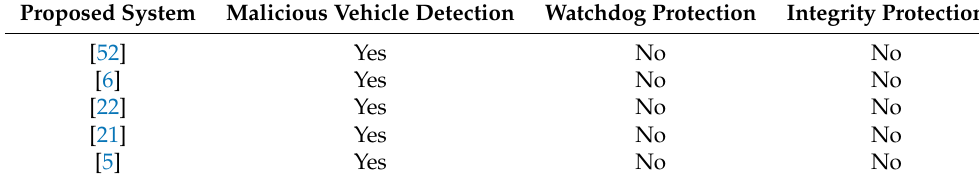
Table 3. Results